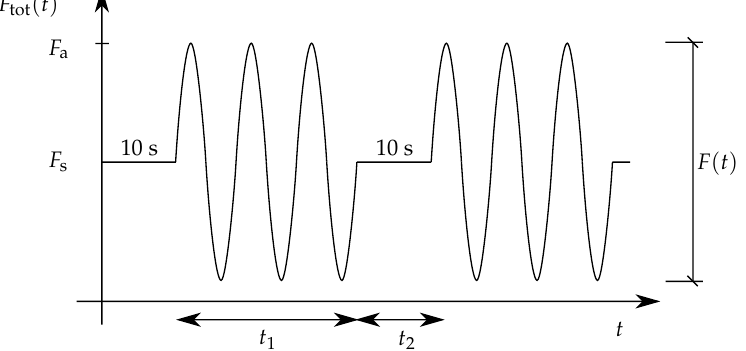
Figure 7. Measured force in time during the test; during the time interval t 1 , the sample is displacement controlled, and during the time interval t 2 , the sample is force